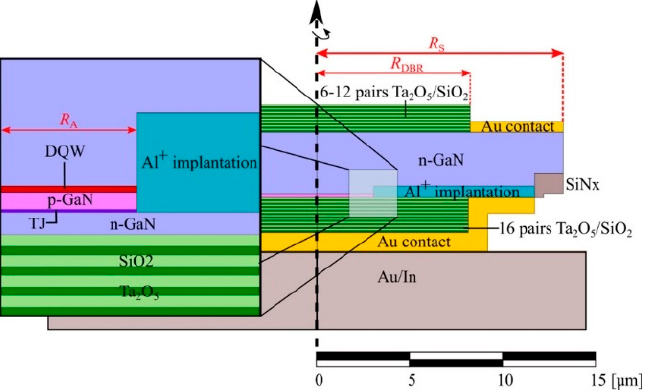
Figure 7. A schematic of a VSCEL. Reprinted from [79], Copyright 2020, with permission from Elsevier. Table 2. Recently proposed high-speed LED and LD-based VLC